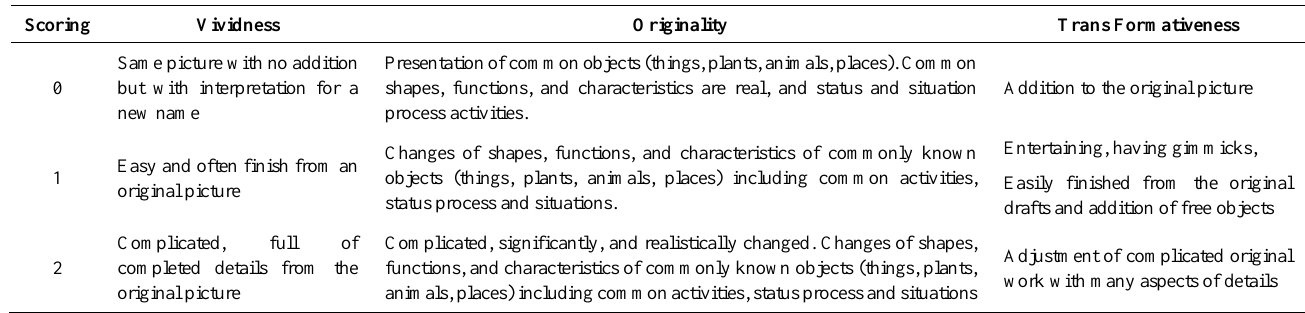
Table 3. Scoring criteria for Test of Creative Imagery Abilities (TCIA)